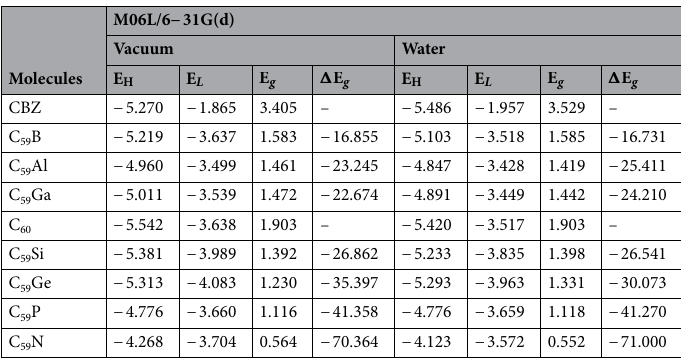
Table 1. Energies (in eV) of the frontier orbitals and HOMO–LUMO gap for the doped fullerenes and its percentual variation upon complexation of CBZ ( (cid:31) E g in % ) as determined at the M06L/6-31G(d)//wB97XD/6- 31G(d) level of theory.